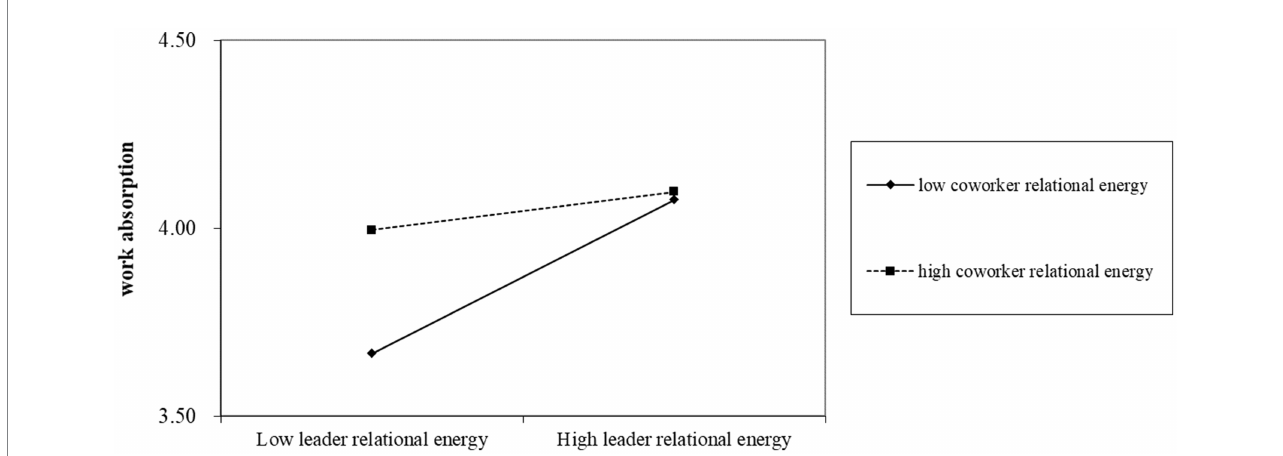
FIGURE 2 The interactive effect of leader relational energy and coworker relational energy on work